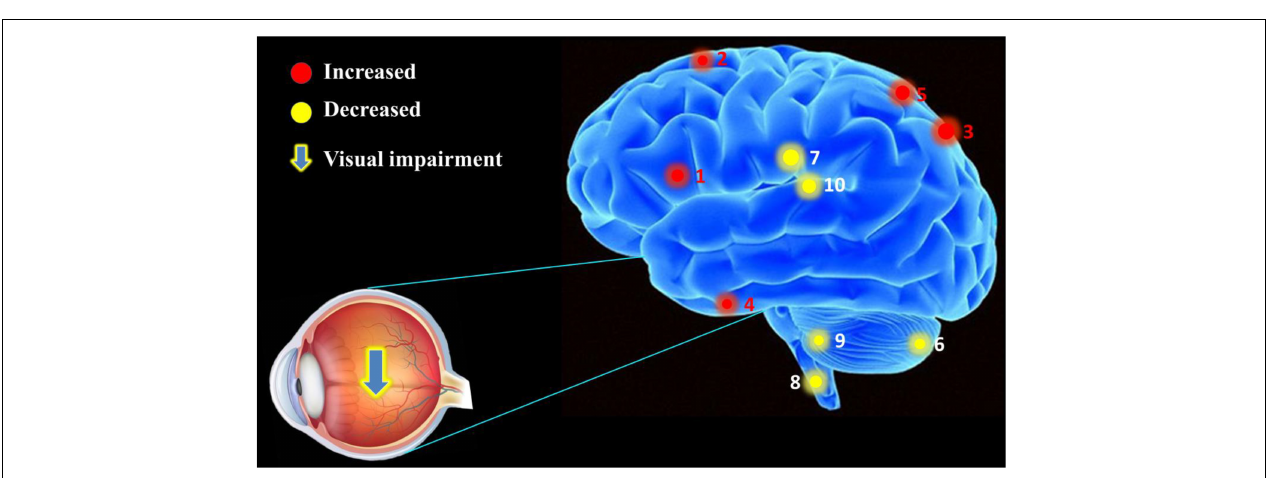
FIGURE 6 | The mean FC values of cerebrum in AMD participants. Compared with HCs, the AMDs showed abnormal signals in specific cerebral regions as followed: 1. inferior frontal gyrus (left vAI, t = 4.309; left PI, t = 4.419), 2. superior frontal gyrus ( t = 4.122), 3. inferior parietal lobule ( t = 3.945), 4. rectal gyrus ( t = 3.986), 5. superior parietal lobule ( t = 5.196), 6. cerebellum posterior lobe (left vAI, t = –4.547; right vAI, t = –3.478; right dVI, t = –4.632), 7. middle cingulate gyrus ( t = –3.609), 8. medulla ( t = –3.478), 9. cerebellum anterior lobe ( t = –3.908), and 10. thalamus ( t = –3.875).